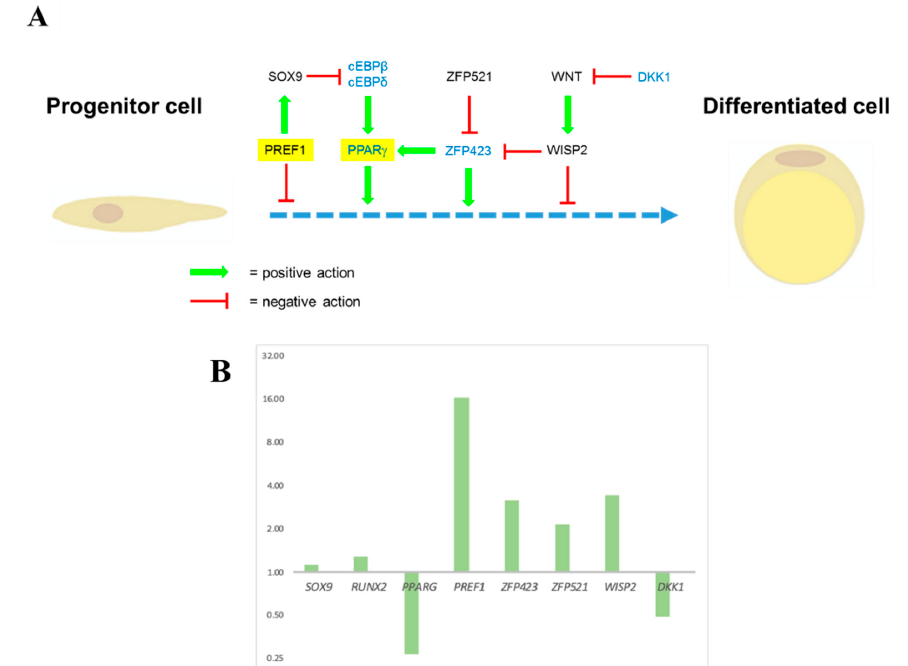
Figure 10. Expression ratio measured by RT-qPCR of some essential genes which regulate positively or negatively the adipocyte differentiation process. ( A ) The illustration schematically shows the relationship between different factors that positively or negatively controls adipogenesis. Two of them are particularly important: PPREF1 is known to inhibit adipogenesis and, PPARG, considered the master regulator of adipose tissue development and differentiation. The blue dotted line represents the various differentiation stages that lead to a mature adipocyte starting from a progenitor cell. Further information and references about the marker genes used can be found in Supplementary Material, Tables S6 and S7. ( B ). Representative experiment showing differences in marker genes expression between ASC52telo cells grown in static 2D or defined dynamic 3D conditions. The normalized expression ratio of the different markers for the defined dynamic 3D tests is related to the static 2D condition values.